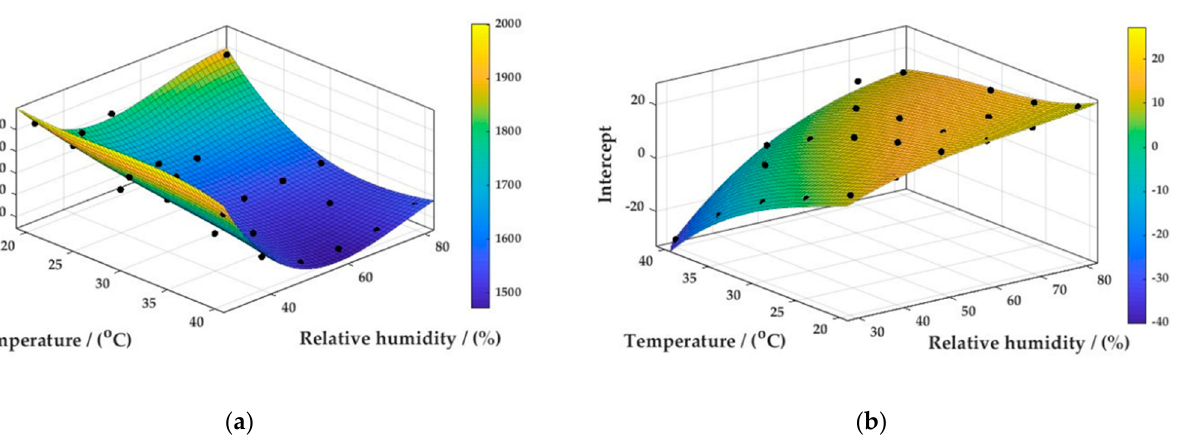
Figure 8. MATLAB surface function describing the gradients ( a ) and intercepts ( b ) resulting from the calibration curves measured across an environmental envelope.